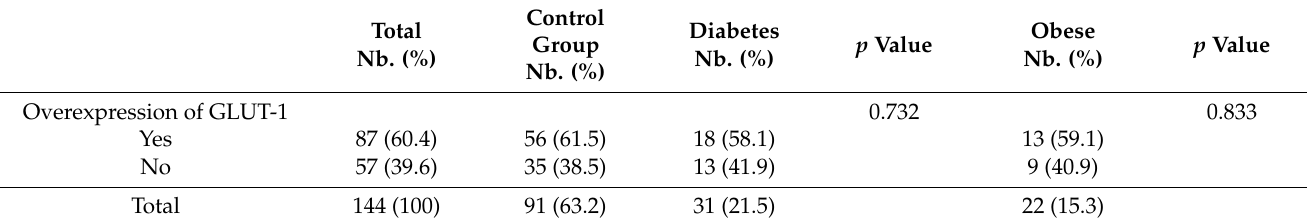
Table 6. Comparison of GLUT-1 expression between the diabetic and obese patients and the control group.